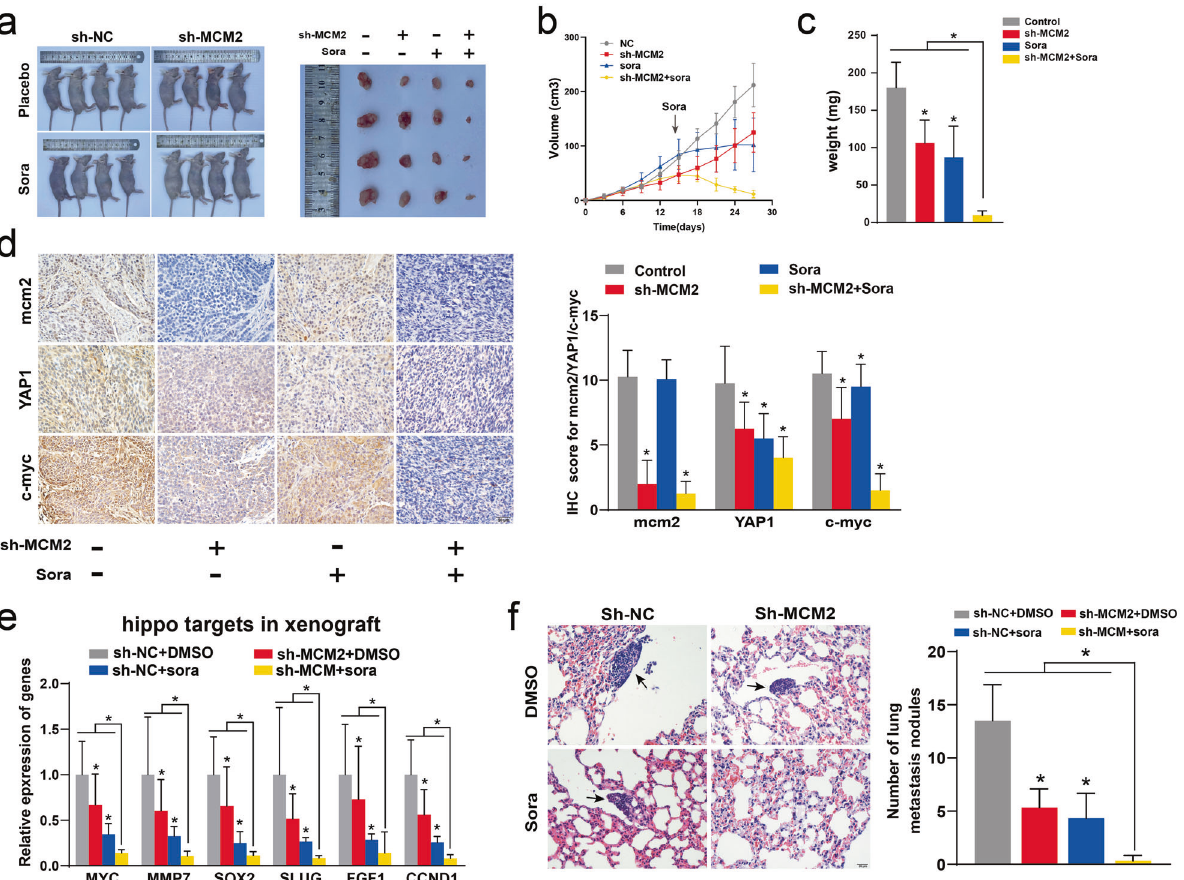
Fig. 7 Down-regulation of MCM2 inhibited hippo signal and enhanced the ef fi cacy of sorafenib in mice. a Photographs of nude mice in xenograft models and Photograph of a transplanted tumors removed from under the skin of nude mice. b Volume curve of the transplantation tumors during the experimental cycle, based on the diameter; c The weight of the transplanted tumors, when removed from the nude mice. d Representative images of immunohistochemistry for mcm2, YAP1 and c-myc in transplantation tumors and corresponding histograms. e The mRNA expression levels of MYC, MMP7, SOX2, Slug2, FGF1, and CCND1 in transplantation tumors. f Representative picture of pulmonary metastases after hematoxylin-eosin staining and corresponding statistical charts. Data are shown as the mean ± SD from independent experiments. * P < 0.05. sora,